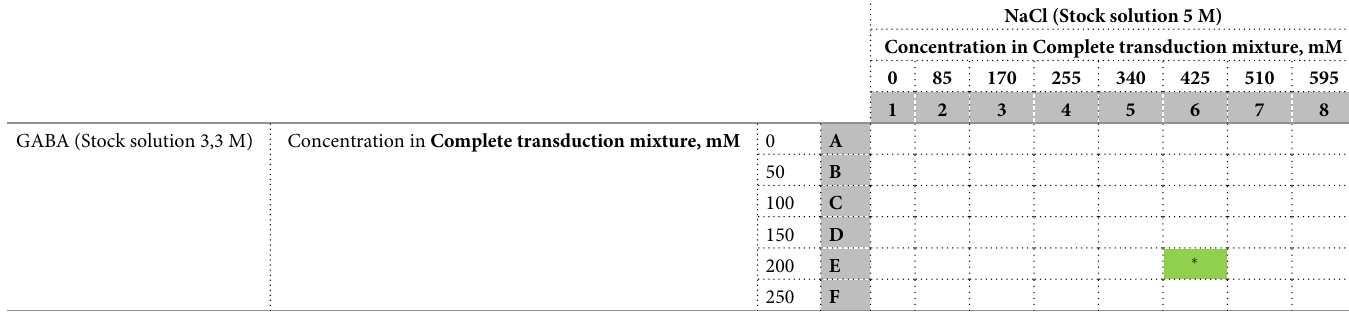
Table 3. NaCl and GABA concentrations optimization during iTOP protein transduction (48-well transduction plate layout).